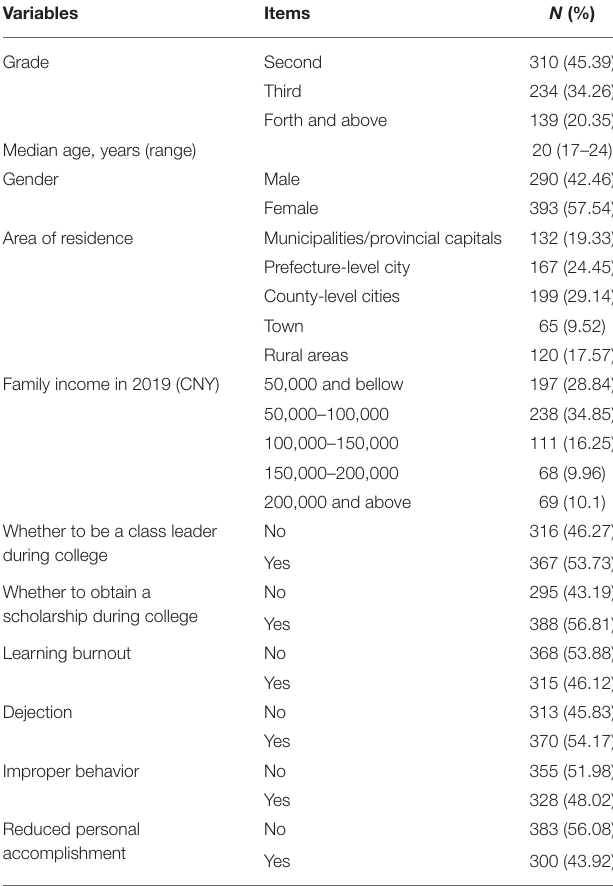
TABLE 1 | Demographic characteristics and learning burnout of